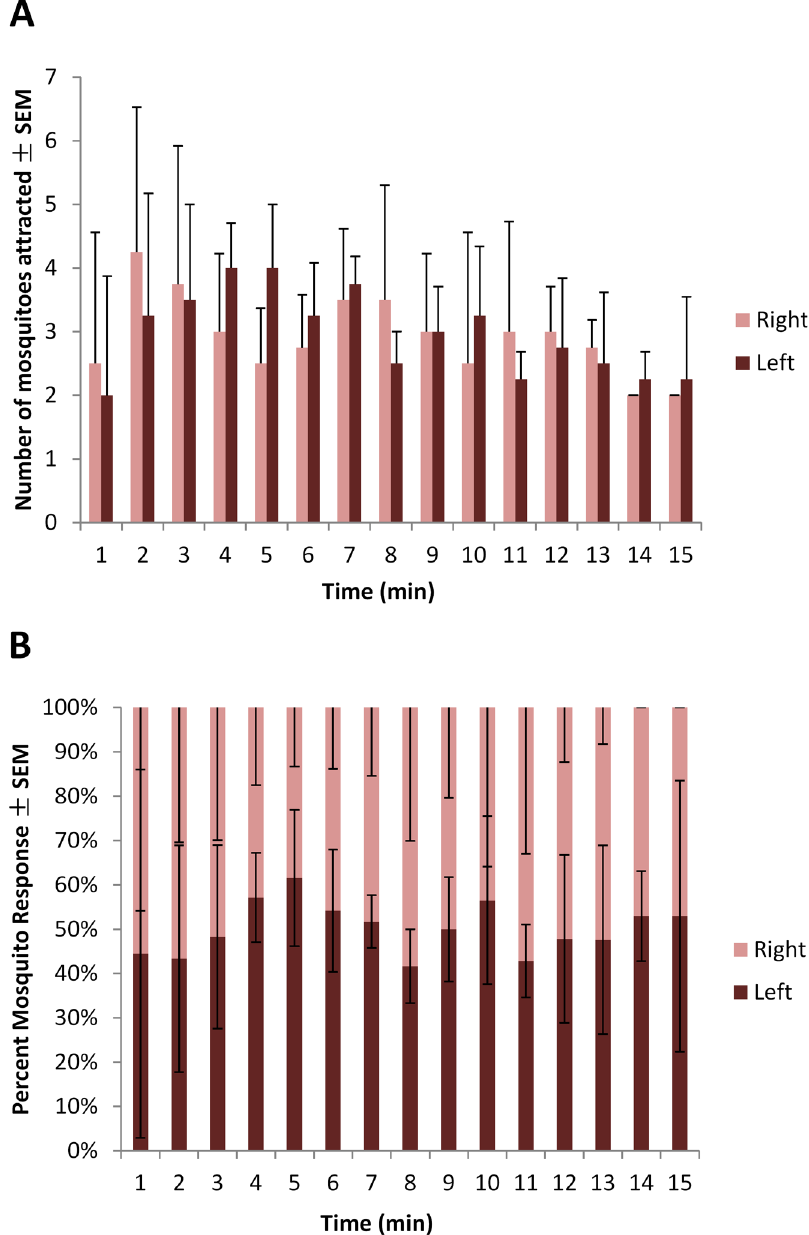
Fig 2. Mean number (A) and (B) percent of 5-8-d-old adult female Ae . aegypti mosquitos attracted per minute ± SEM to blood-feeders treated with TSB located on the right and left sides of the top of a